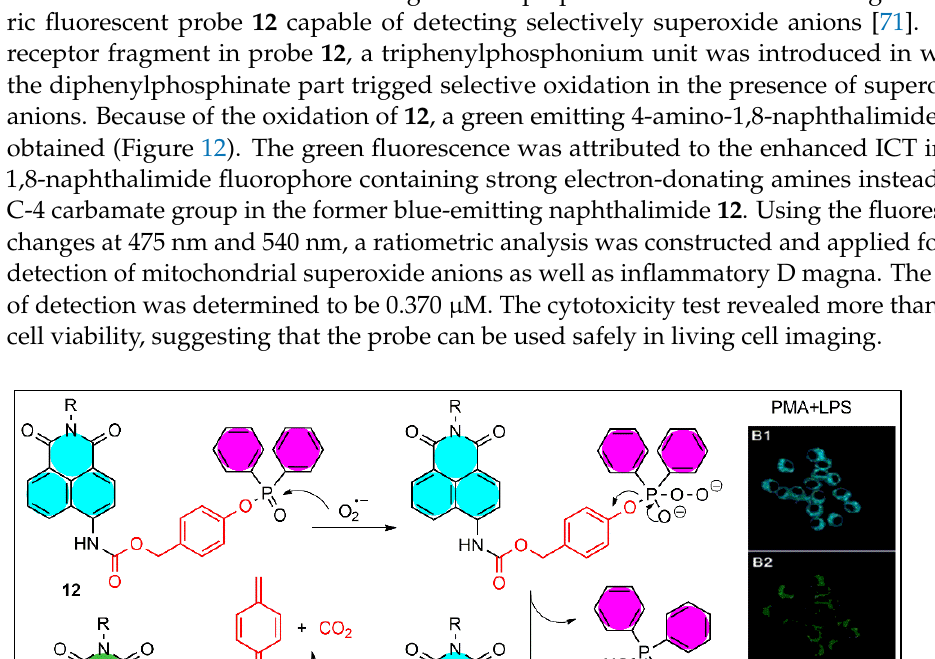
Figure 13. Proposed sensing mechanism for Sec activation of 13 . The in situ fluorescence changes of Hela cells stimulated to Na 2 SeO 3 (5 μM) for different time s (1, 2, 6, 12 h), and then incubated with 13 (5 μM). Adapted with permission from [ 72]. Copyright (2017) The Royal Society of Chem- istry. Tyrosinase is a polyphenolic oxidase enzyme with clinical importance due to its as- sociation with the progress of some diseases such as Parkinson, dopamine neurotoxicity, schizophrenia, and melanoma cancer [73 – 75]. This encouraged Sidhu et al. to obtain the 1,8-naphthalimide 14 as an efficient fluorescent ratiometric probe for intracellular imaging of tyrosinase (Figure 14) [76].